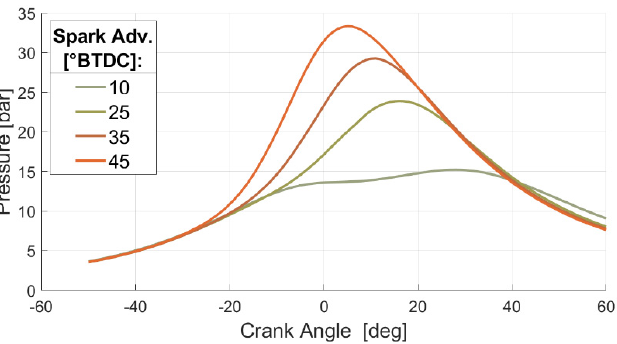
Figure 2. In-cylinder pressure developments for each spark advance (SES: 75%).